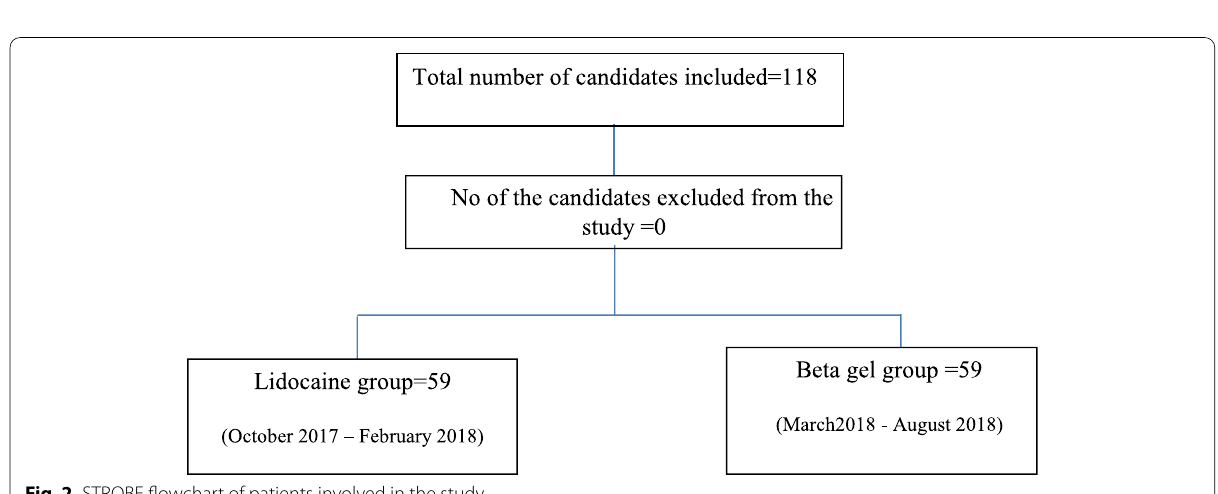
Fig. 2 STROBE flowchart of patients involved in the